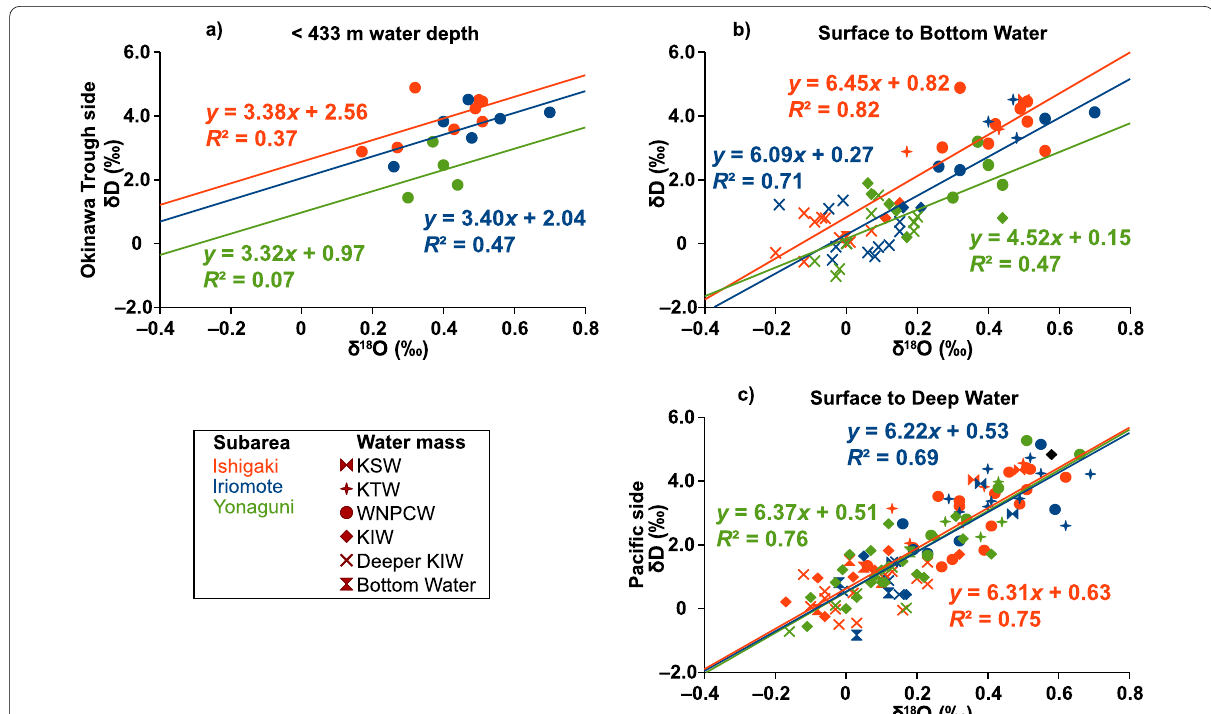
Fig. 7 δ 18 O–δD cross-plots for seawater on the Okinawa Trough ( a , b ) and Pacific ( c ) sides of the study area. a Cross-plots for < 433 m depth; b , c plots for seawater collected from all depths. Outliers for which δ 18 O and/or δD values are not within the mean masses are not shown. For abbreviations, see Fig.